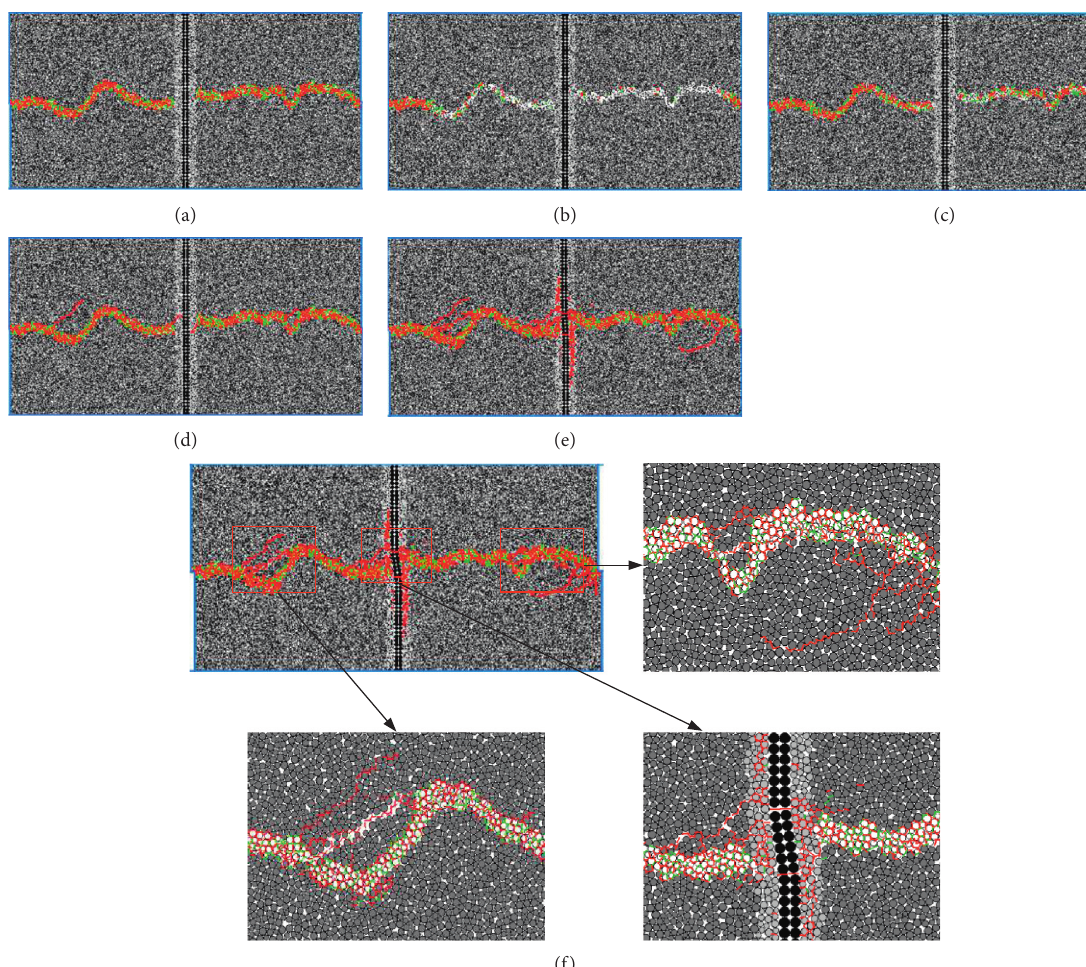
Figure 17: The development of micro-cracks of bolted infilled rock joints: (a) 0.01 mm; (b) 0.02 mm; (c) 0.05 mm; (d) 0.1 mm; (e) 0.5 mm; (f) 1.0